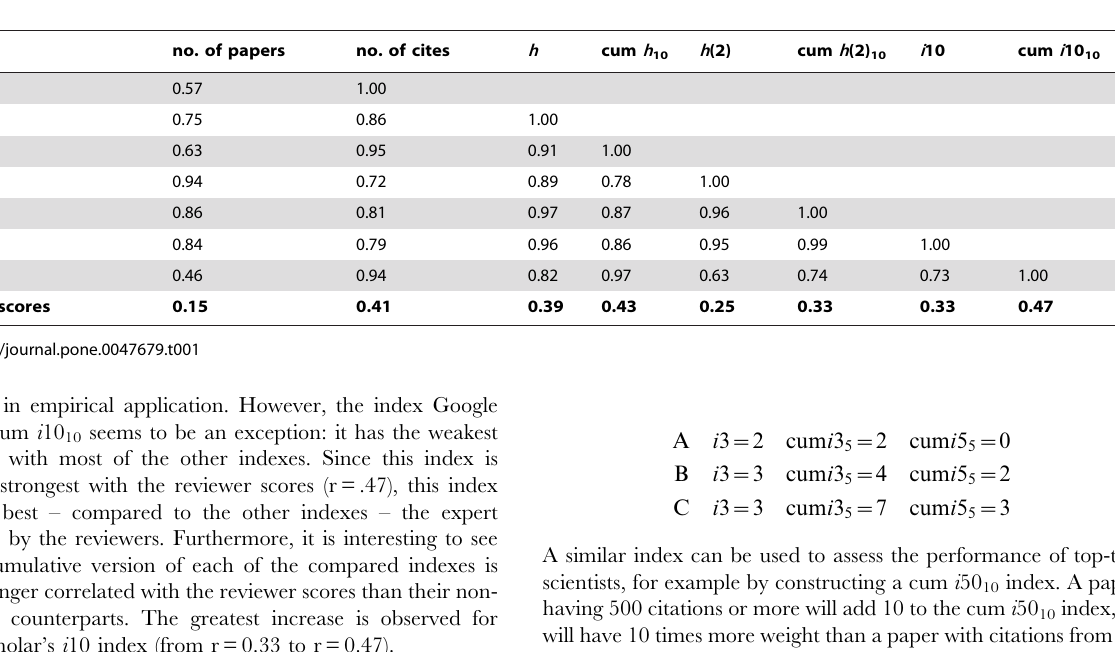
Table 1. Spearman’s rank-order correlations between the different indexes and the reviewer scores ( n = 288).